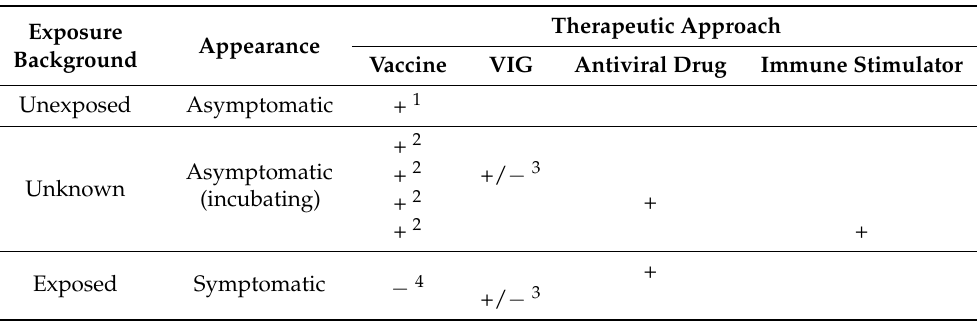
Table 2. Approaches for prevention and treatment of